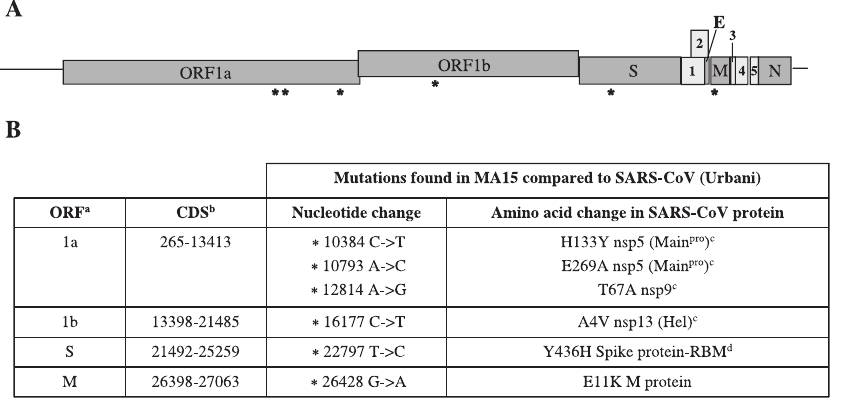
Figure 1. Schematic Diagram of SARS-CoV Genome Indicating Mutations Found in MA15 Virus (A) The 29,727 nucleotide positive-sense RNA genome of SARS-CoV is depicted in this to-scale drawing with ORFs indicated by shaded boxes (dark gray, structural and non-structural proteins; light gray, accessory genes X1–X5 [37]; and straight lines, non-coding regions). Asterisks indicate the sites of the six nucleotide changes (compared with the published SARS-CoV (Urbani) sequence) resulting in six coding mutations found in the mouse-adapted SARS-CoV (MA15). (B) The six mutations found in MA15. a ORF, open reading frame. b CDS, coding sequence, sequence of nucleotides that corresponds with the sequence of amino acids in a protein (location includes start and stop codon). c nsp, non-structural protein, cleavage product of ORF 1ab; Main pro , main 3C-like protease; Hel, helicase. d RBM, receptor binding motif (amino acids 424–494).